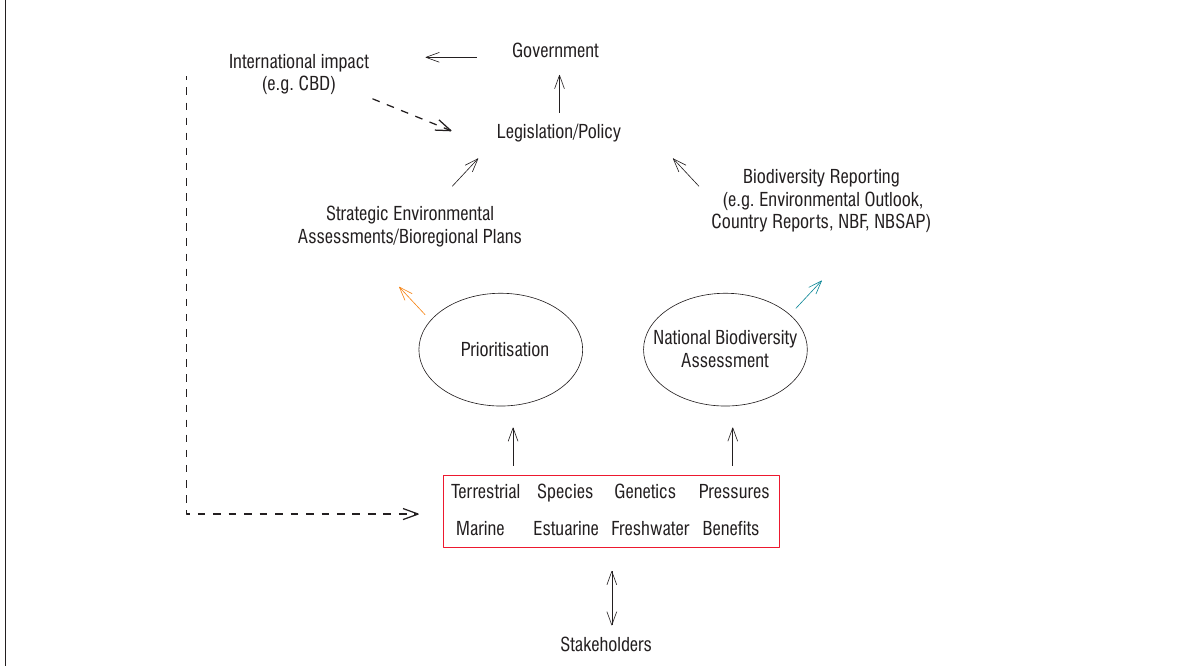
CBD, Convention on Biodiversity; NBSAP, National Biodiversity Strategy and Action Plans; NBF, National Biodiversity Framework Figure 2: The National Biodiversity Assessment is a multistakeholder report 18 and assesses the state of South Africa’s biodiversity, across terrestrial and aquatic environments, emphasising spatial (mapped) information for both ecosystems and species. It has direct and indirect impacts, with the latter feeding into both national and international policy through various other strategic and reporting